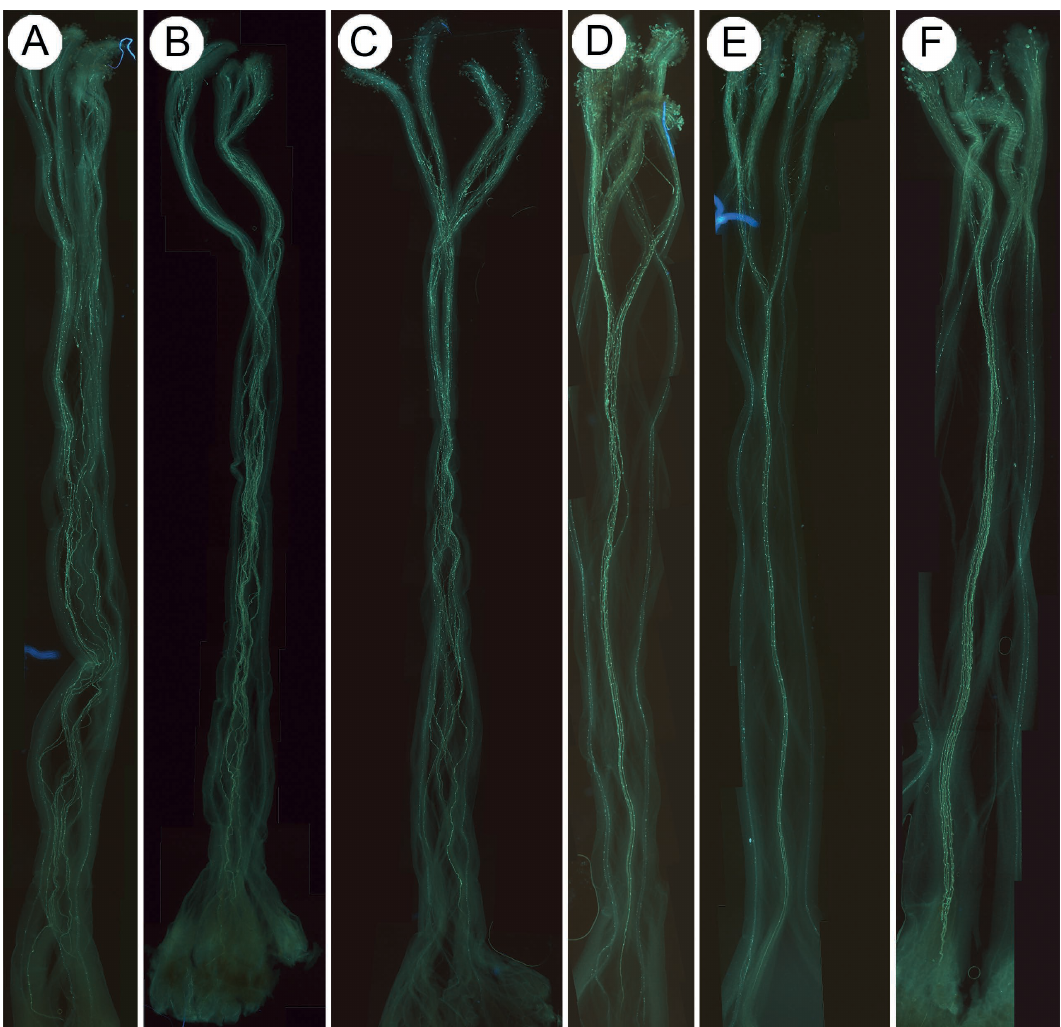
Figure 4 – SEM micrographs of pollen grains of C. subcordata . A . Pollen of L-morph flowers. B . Pollen of S-morph flowers.